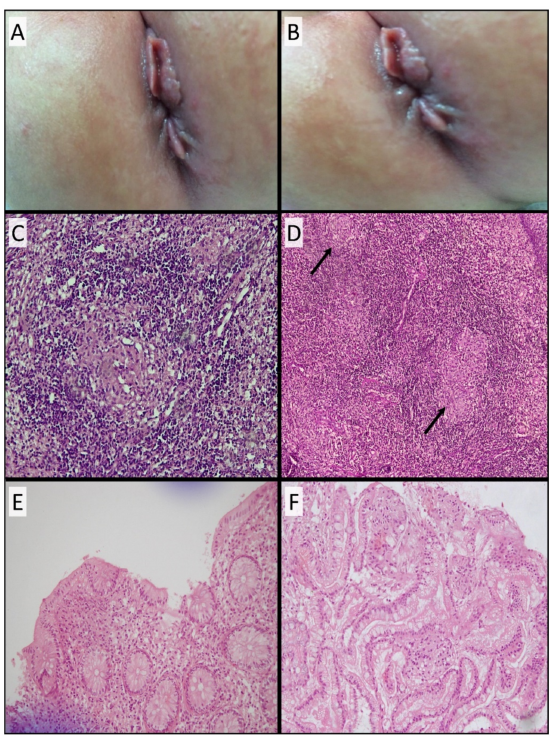
Figure 3. Histopathological description. ( A , B ) Patient’s skin tags. ( C , D ) Anal fissure and skin tag biopsies showing noncaseating granuloma with heavy lymphohistiocytic inflammation, along with several epithelioid non-caseating granulomas (arrows). These had a thick rim of lymphocytes. ( E ) Colonic biopsy showing normal crypt architecture with no distortion, branching, dropped glands, or basal plasmacytosis. Goblet cells were preserved and there was no evidence of pyloric metaplasia. Chronic inflammatory infiltrate was noted along with a few well-formed epithelioid noncaseating granulomas. These had a thin rim of lymphocytes. Occasional giant cells were identified. ( F ) Ileal biopsy showing normal glandular architecture without